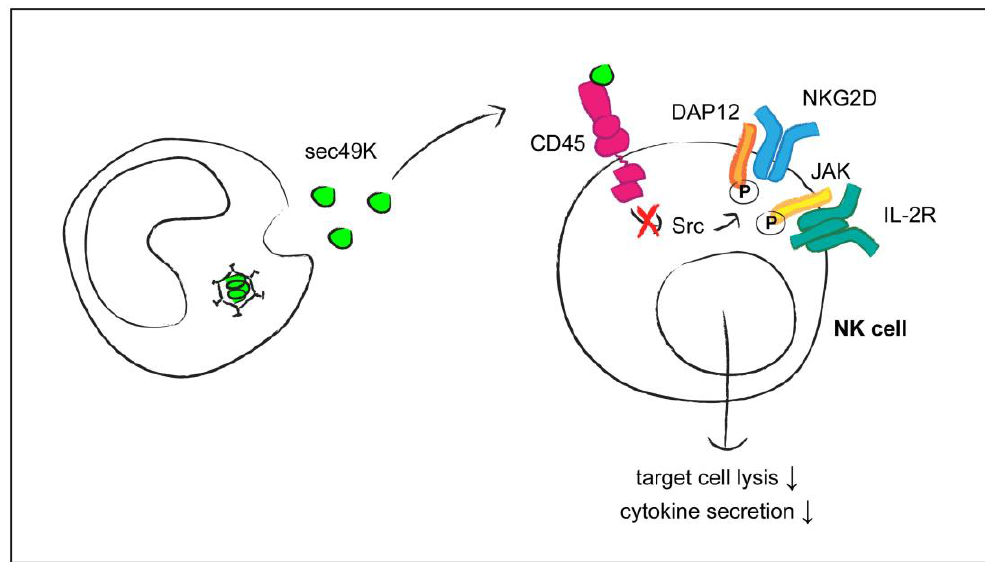
Figure 1. Modulation of NK cell functions by the secreted adenovirus type 19a sec49K protein (as described in reference [40]). Binding of sec49K to CD45 results in altered activity of Src kinases, affecting the phosphorylation of the adapter molecule DAP12 that is associated with the activating NK cell receptor NKG2D. CD45 can also regulate the phosphorylation of JAK kinases associated with the interleukin-2 receptor (IL-2R). One report has implicated CD45 in the apoptosis of CD4 T lymphocytes induced by the